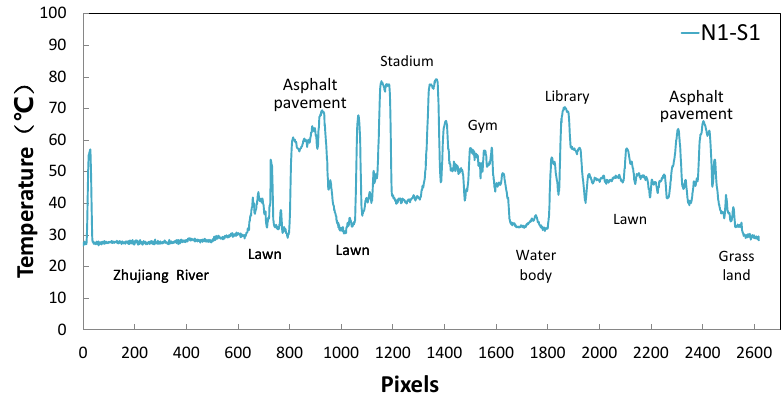
Figure 12. LST on profile N1–S1 (Lines marked in Figure 9).